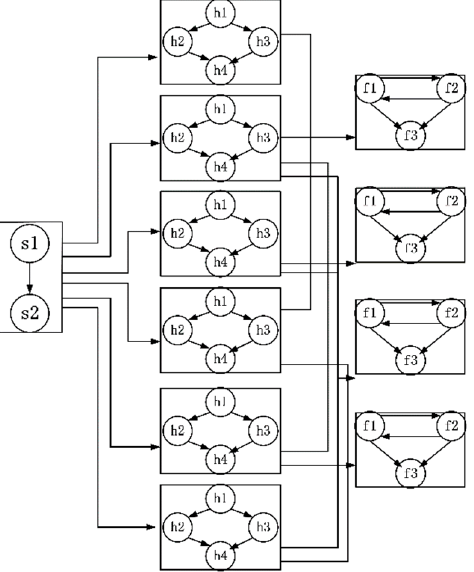
Figure 4. Life prediction model of an FS with a DFT frame and a SHA description.